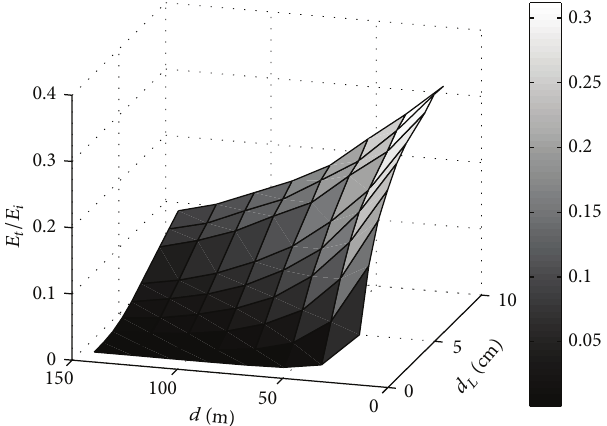
Figure 5: Mean transmission values versus different propagation distances and thickness of constituents (equal) layers.